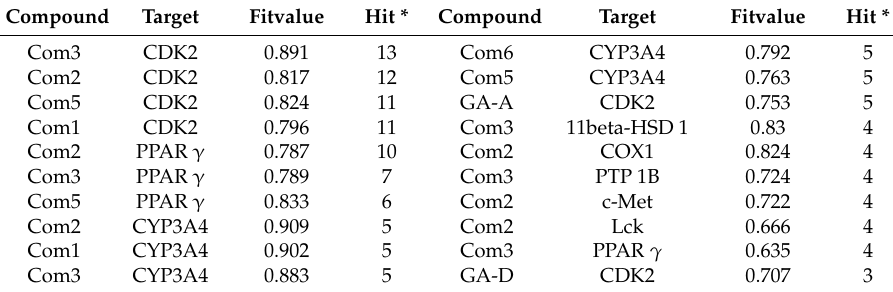
Table 1. Top 20 interaction information of GTs and targets.